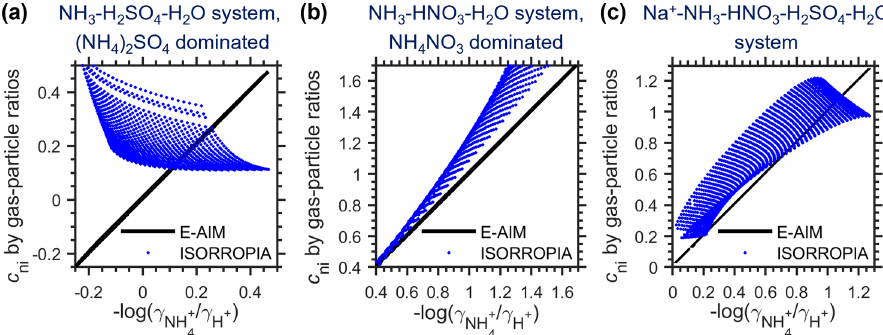
Figure 2. Comparison of different c ni estimation methods for three representative aerosol systems. The c ni are compared under the same conditions (i.e., same RH, temperature and chemical profiles). The x values are c ni estimated by activity coefficients (Eq. 14b) with the E-AIM model, and the y values include c ni estimated by gas / particle ratios (Eq. 14c) with the E-AIM (black lines) and ISORROPIA (blue dots) models. The systems are the same as in Fig. 1.